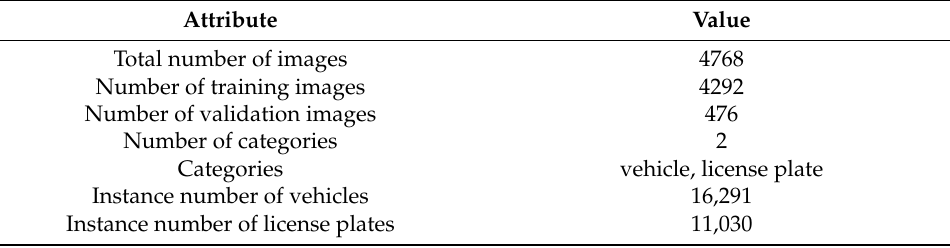
Table 1. The attributes of the vehicle detection